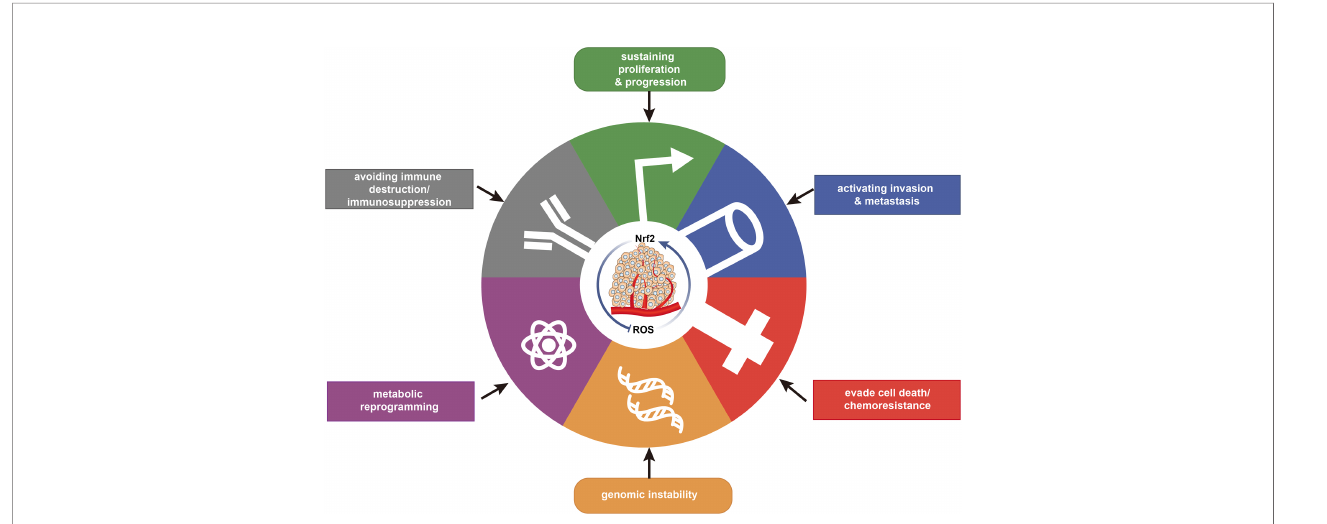
FIGURE 3 | Relationship of redox with the major hallmarks of cancer. Redox regulation is associated with the hallmarks of cancer, maintaining redox homeostasis and impacting cancer